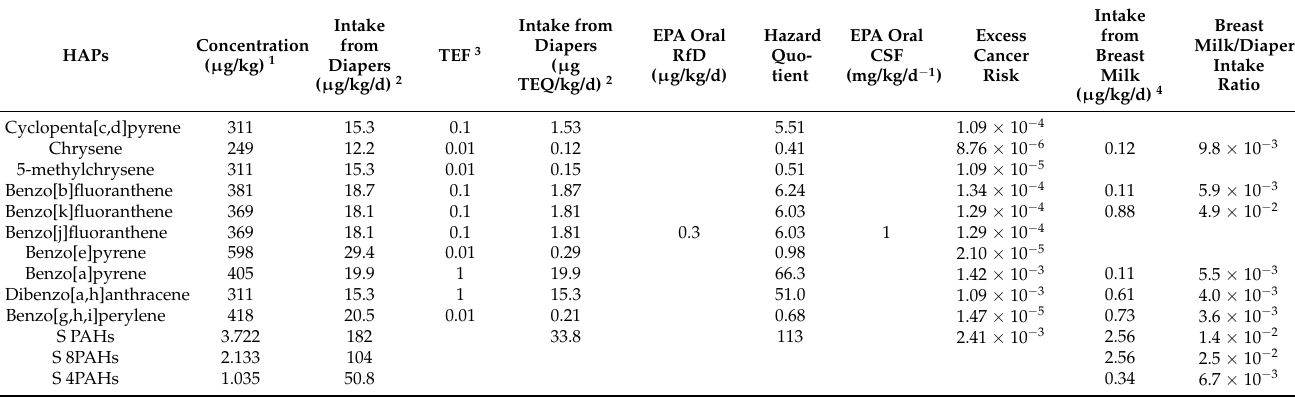
Table 4. Risk assessment of polycyclic aromatic hydrocarbons (PAHs) in diapers with the scenario 2.2 equation and comparison of the intake from diapers with that from breast